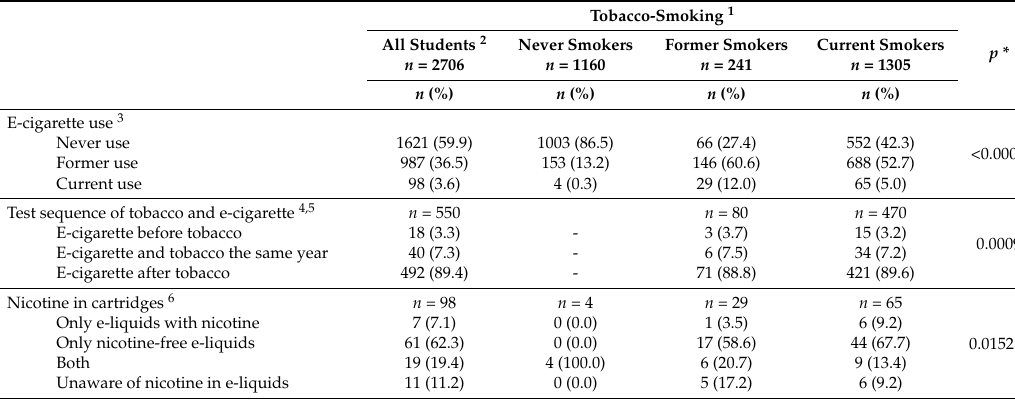
Table 2. E-cigarette use according to smoking status.